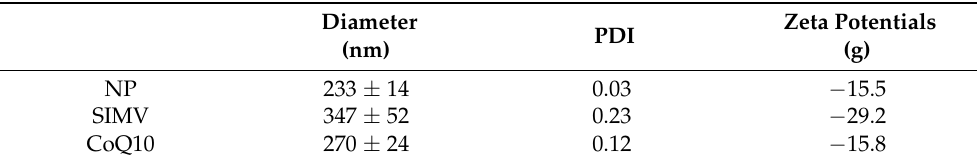
Table 1. Characteristics of pure and loaded nanoparticles (NP) determined with dynamic light scattering (DLS) of the NP.